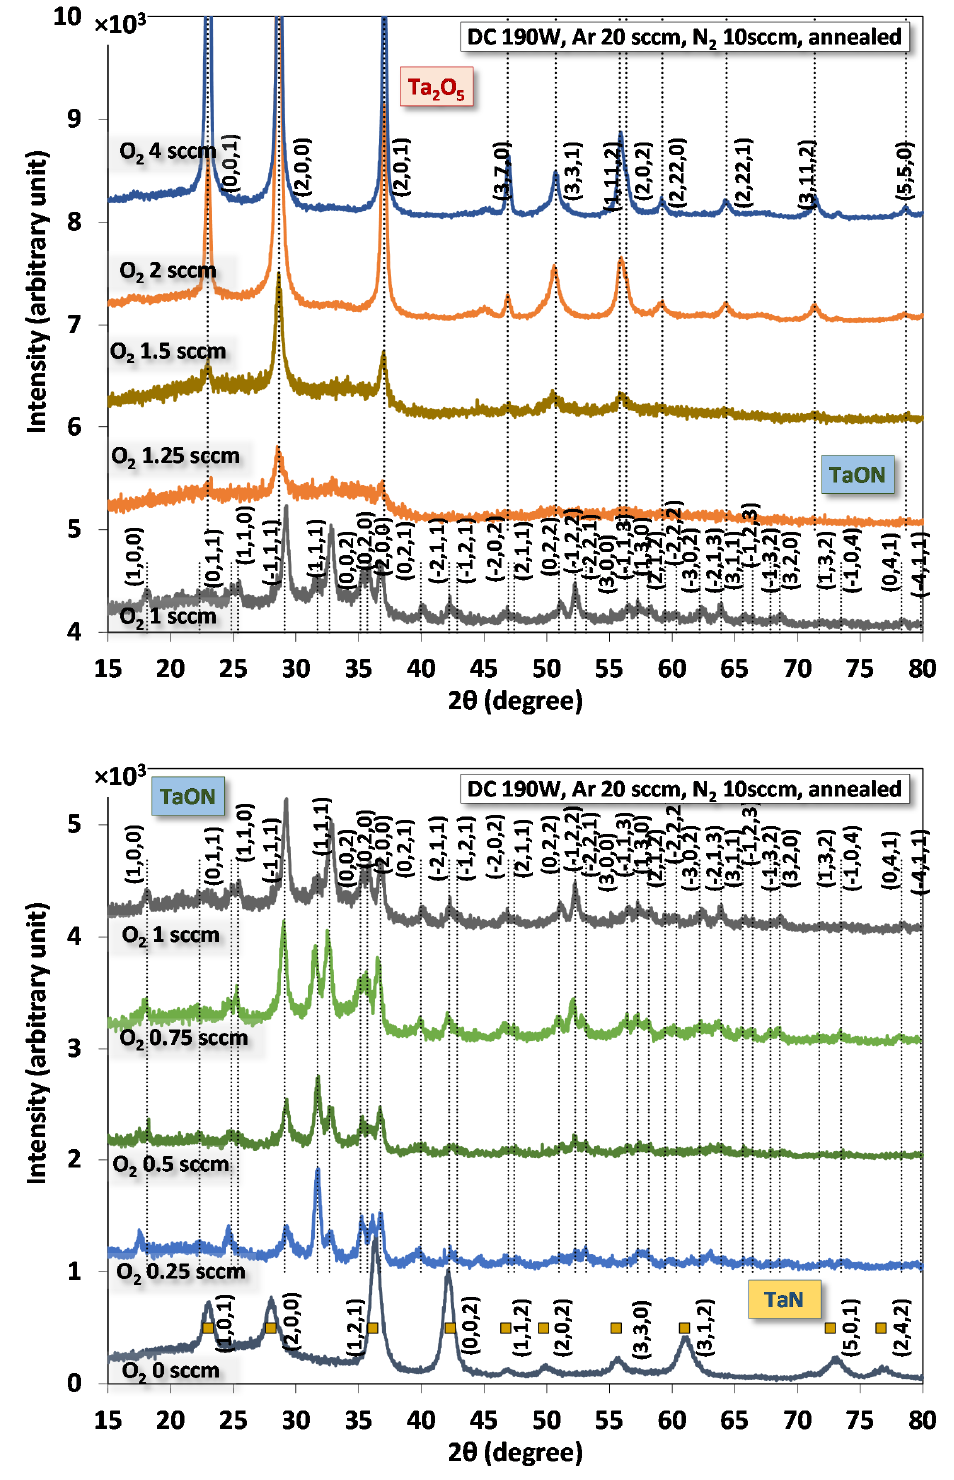
Figure 3. XRD patterns of annealed films deposited under different oxygen flow rates.